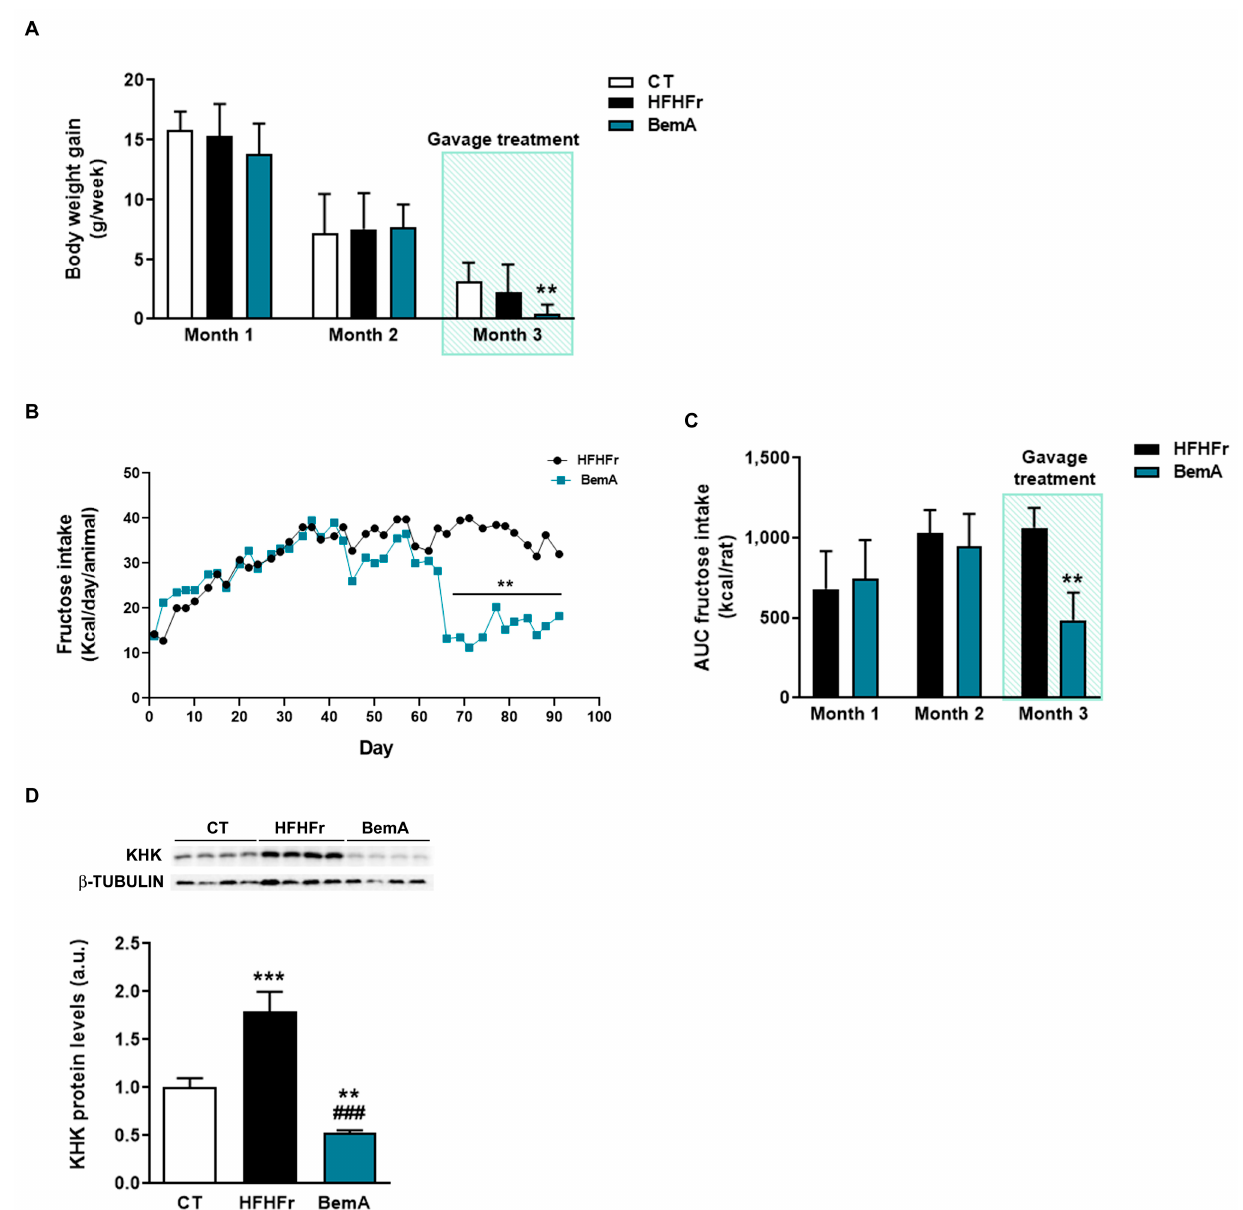
Figure 2. Bempedoic acid treatment reduces body weight gain, fructose intake, and KHK expression. ( A ) Body weight gain of control (CT), high-fat, high-fructose (HFHFr), and bempedoic acid (BemA)- treated rats during the three months of treatment. ( B ) Fructose intake of the rats from the HFHFr and BemA groups during treatment. ( C ) Area under the curve (AUC) of fructose intake of the rats from the HFHFr and BemA groups corresponding to the first two months and last month of treatment. ( D ) Protein expression of KHK in liver samples from CT, HFHFr, and BemA groups. In the upper part of the figure, representative Western blot bands corresponding to the three different study groups are shown. The results are expressed as the mean ± SD of 7–8 animals/group. For Western blot analysis, four pooled samples for each condition, obtained by mixing equal amounts of tissue from two rats, were used. a.u.: arbitrary units. Data were analyzed by one-way ANOVA, followed by Tukey’s post-hoc test. ** p < 0.01, *** p < 0.001 compared to CT; ### p < 0.001 compared to